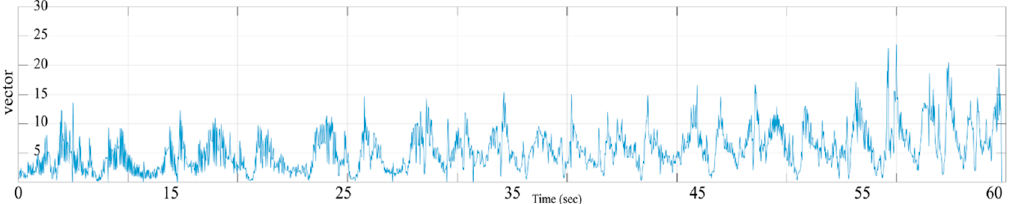
Figure 7. Performed tracking analysis of the user’s motion vector change as a repetitive activity. As time changes, it is possible to analyze the section where the vector changes. It is also possible to enhance the functional ability to move the box to the opposite box without making a mistake by stimulating the proprioceptor through repetitive activities of the user.